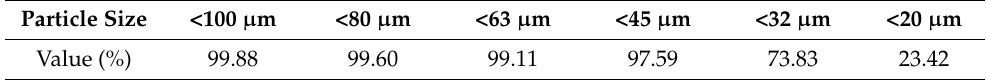
Table 3. Results of the sieve analysis of powders used for fabrication of samples [30].